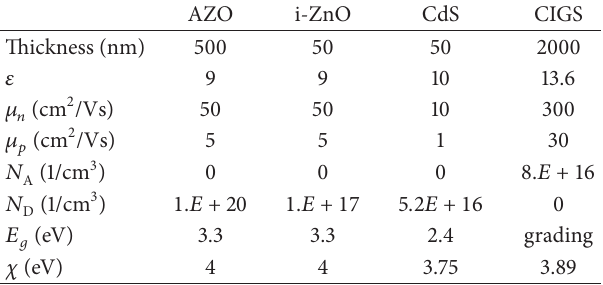
Table 1: Base parameters for CIGS numerical